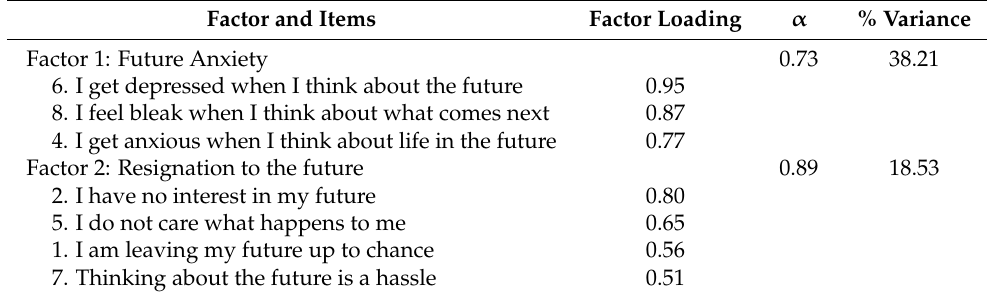
Table 2. Results of the Factor Analysis for The Revised Perceived Future Time Perspective Scale (Principal Factor Method, Promax